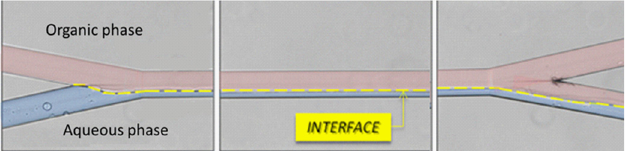
Fig. 2. Example of the position of the interface in the ICC-DY10 microsystem (based on microscope